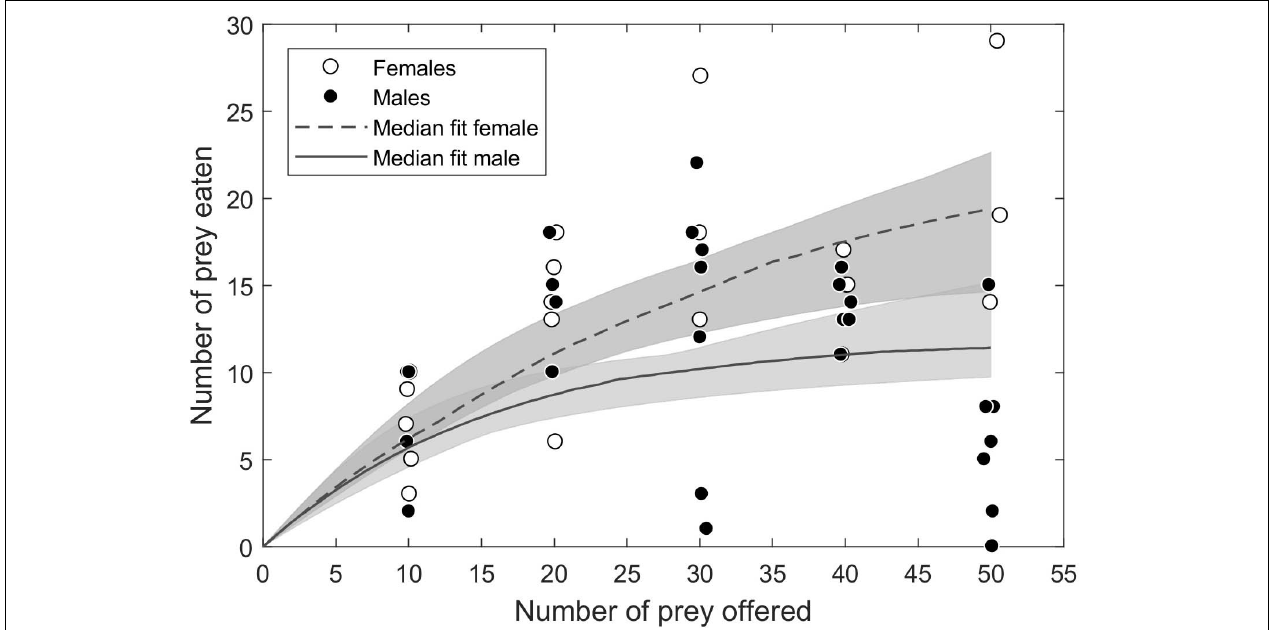
FIGURE 2 | Functional responses of 28 male and 20 female Schizocosa mccooki wolf spiders foraging on flightless Drosophila melanogaster . The closed-form version of the Roger’s Random Predator equation (Eq. 3 in the main text) was fit to 100 bootstrapped data sets to generate a median fit (lines) and 95% confidence intervals. Differences among bootstrapped parameter estimates indicated that the shallower male curve was due to a higher handling time.